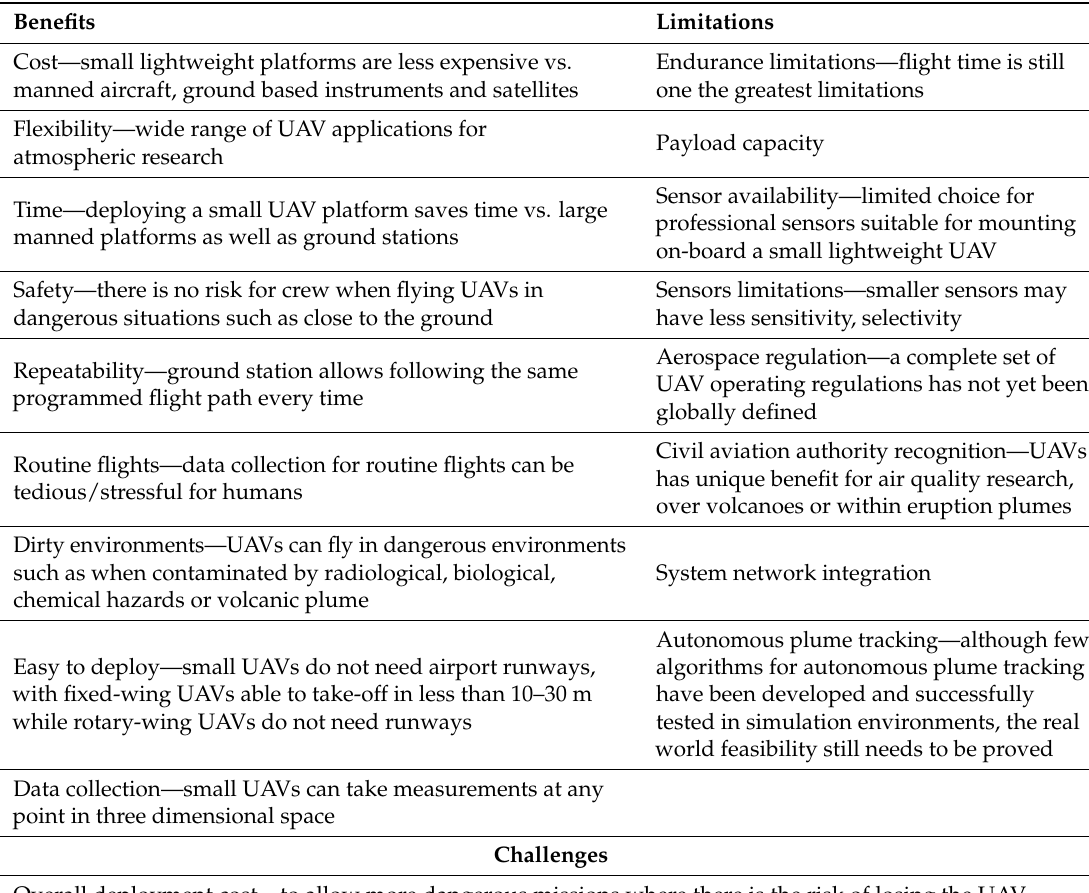
Table 2. Overall benefits and limitations for the use of small lightweight UAVs in the atmospheric research